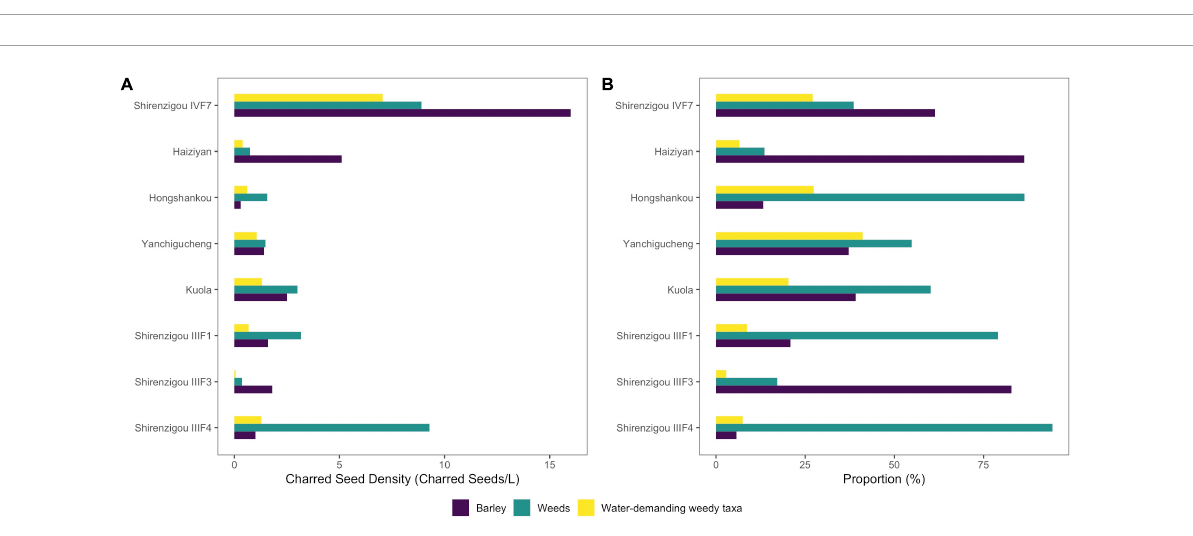
FIGURE3 The density (A) and proportion (B) of charred barley (purple), weeds (including arable weeds and water-demanding weeds, green), and water-demanding weeds (yellow) recovered from eastern Tianshan complexity (ETC) study